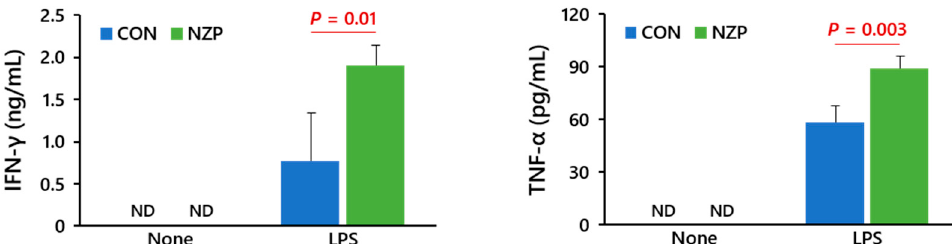
Figure 3. Cytokine production from spleen cells of mice that were fed freeze-dried fermented B. rapa L. Spleen cells from mice were cultured in the presence of LPS (1 µg/mL) for 48 h, and then IFN- γ and TNF- α levels were measured using ELISA. The representative data from 2 independent experiments are shown. Data are means ± SD ( n = 4/group). Significant differences between CON and NZP mice were determined using Student’s t -test.